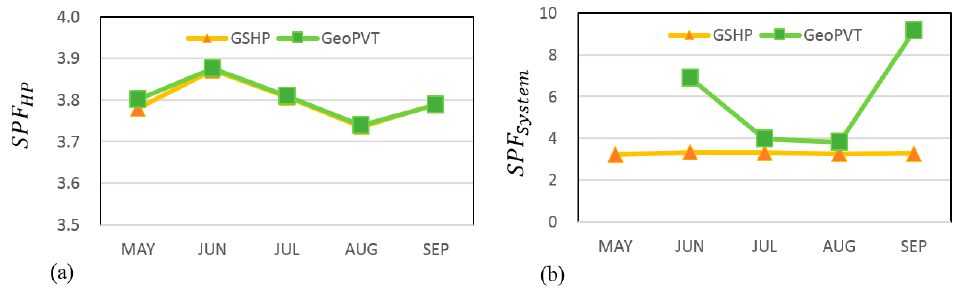
Figure 26. The result of SPF during 24 h operation in cooling season. ( a ) Heat pump; ( b ) system.